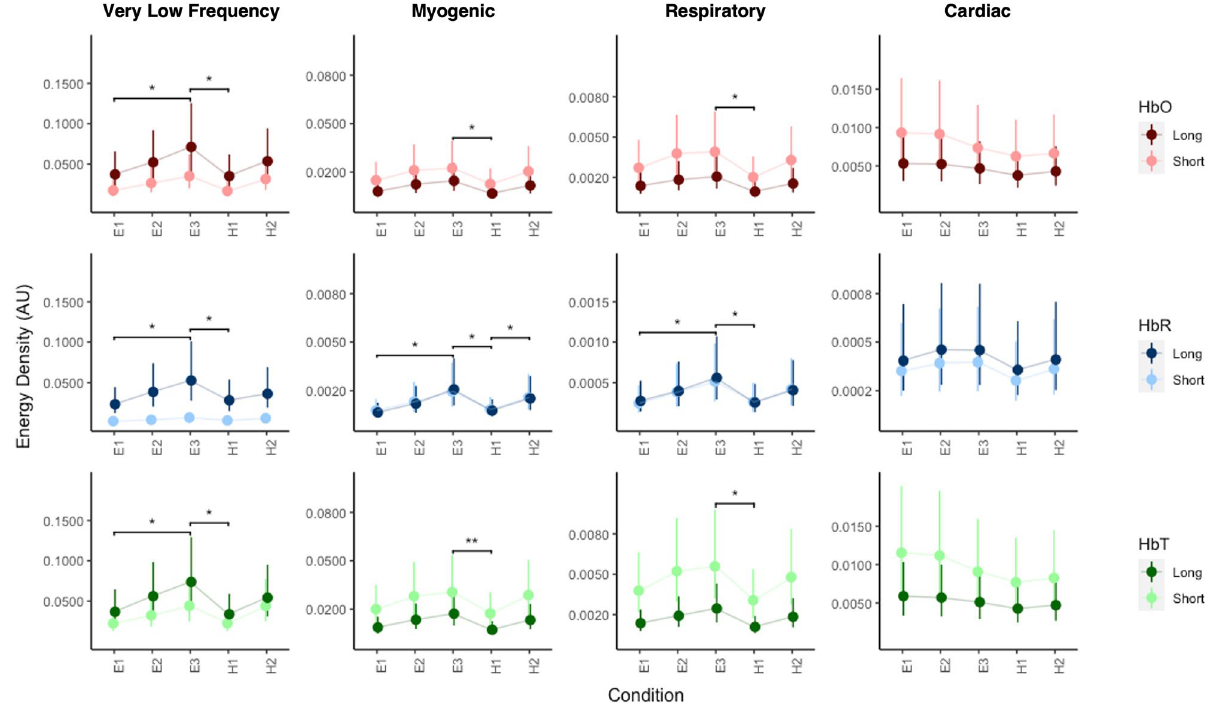
Figure 5. Effect of condition on ε per SDS measurement, band and biomarker. Dots represent mixed model estimates, while lines represent confidence intervals. ** p < 0.01, * p < 0.05. Significance bars reflect p values that were not adjusted using FDR correction. Only conditions pairs that were significant in both SDS measurements are shown here. Figure generated using custom code in R (R Core Team, 2019).